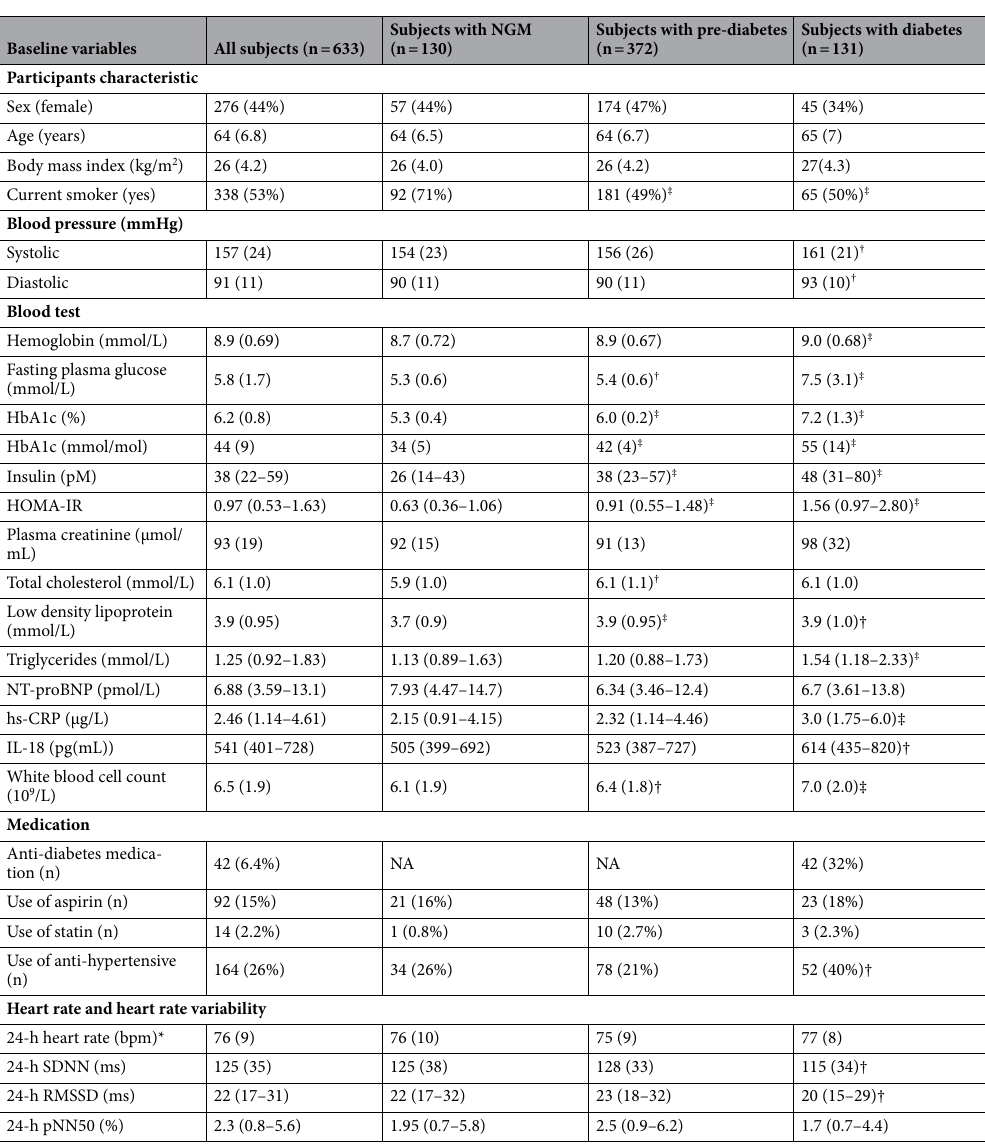
Table 1. Baseline characteristics of subjects with pre-diabetes and diabetes compared to subjects with normal glucose tolerance (NGM). Results are presented as mean ± standard deviation (SD), median (Q1–Q3), or n (%). Antihypertensive medicine indicates the use of one of the following: β-blockers, calcium antagonists, ACE inhibitors, or diuretics. *24-h hear rate has been derived from MEAN NN : 60.000/MEAN NN = average heart rate. † P-value < 0.05. P-value indicates difference from subjects with NGM. ‡ P-value < 0.01. P-value indicates difference from subjects with